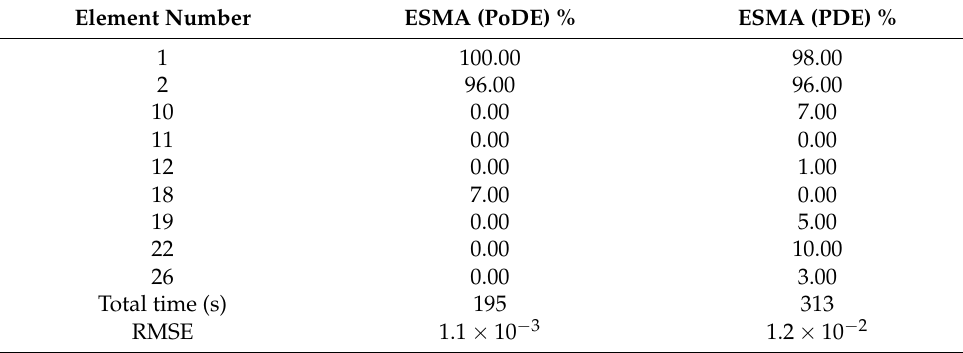
Table 5. PoDEs and PDEs of case 1 for the 31-bar planar truss.